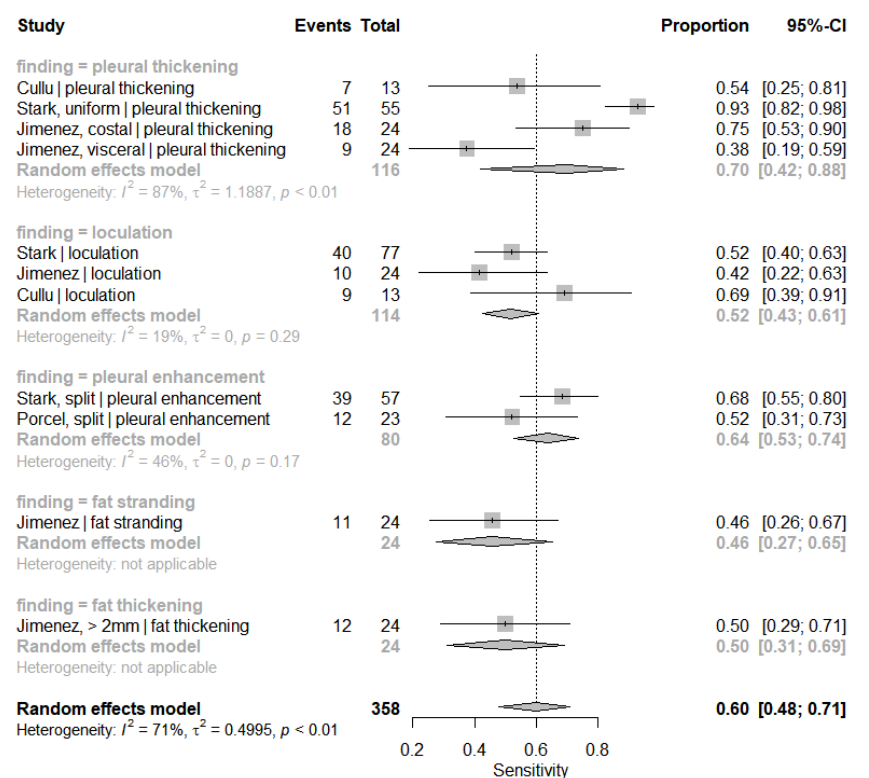
Figure A1: Sensitivity of informative pleural findings to detect pleural empyema in parapneumonic effusions.